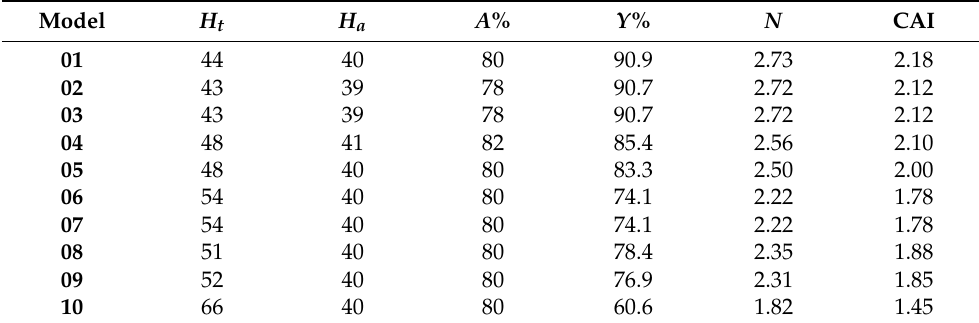
Table 4. Evaluation results of pharmacophore model *.